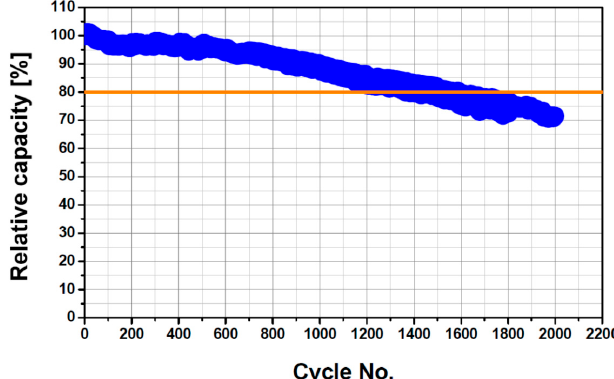
Figure 10. Test results of charging and discharging durability test .